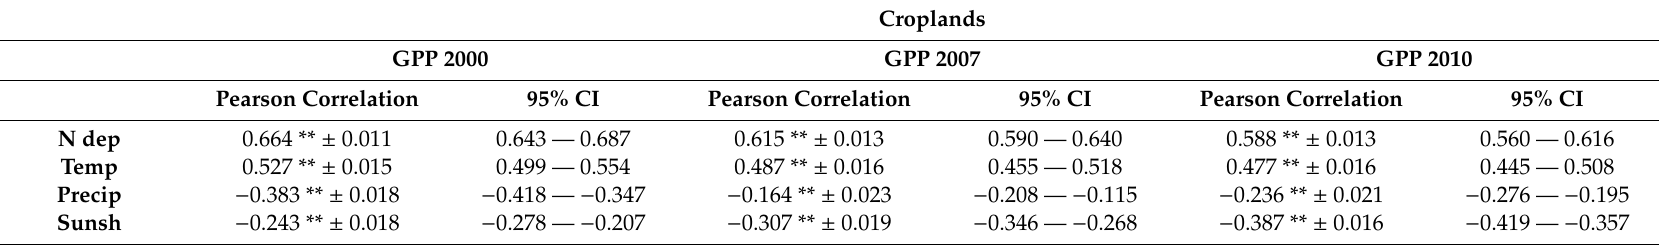
Table A2. Pearson’s correlation between GPP: Gross primary productivity and N dep: N deposition (natural logarithm used only for the year 2000), Temp: Temperature, Precip: Precipitation, and Sunsh: Sunshine, based on a bootstrap of 1000 samples per land cover class and year. ** Statistically significant p < 0.01.